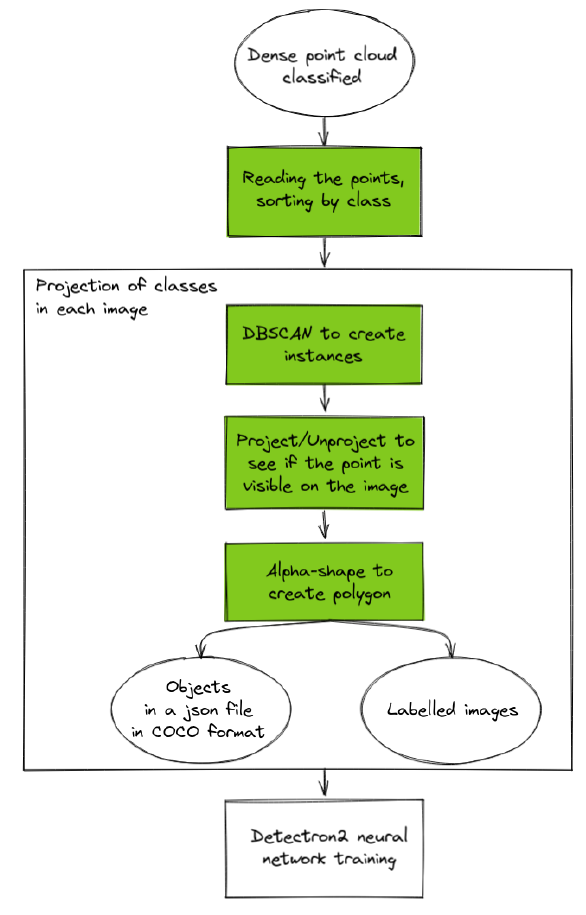
Figure 5: Processing chain of the projection step for semi- automatic labelling. In plain green are the automated steps. Rect- angles indicate processes and ellipses the data.